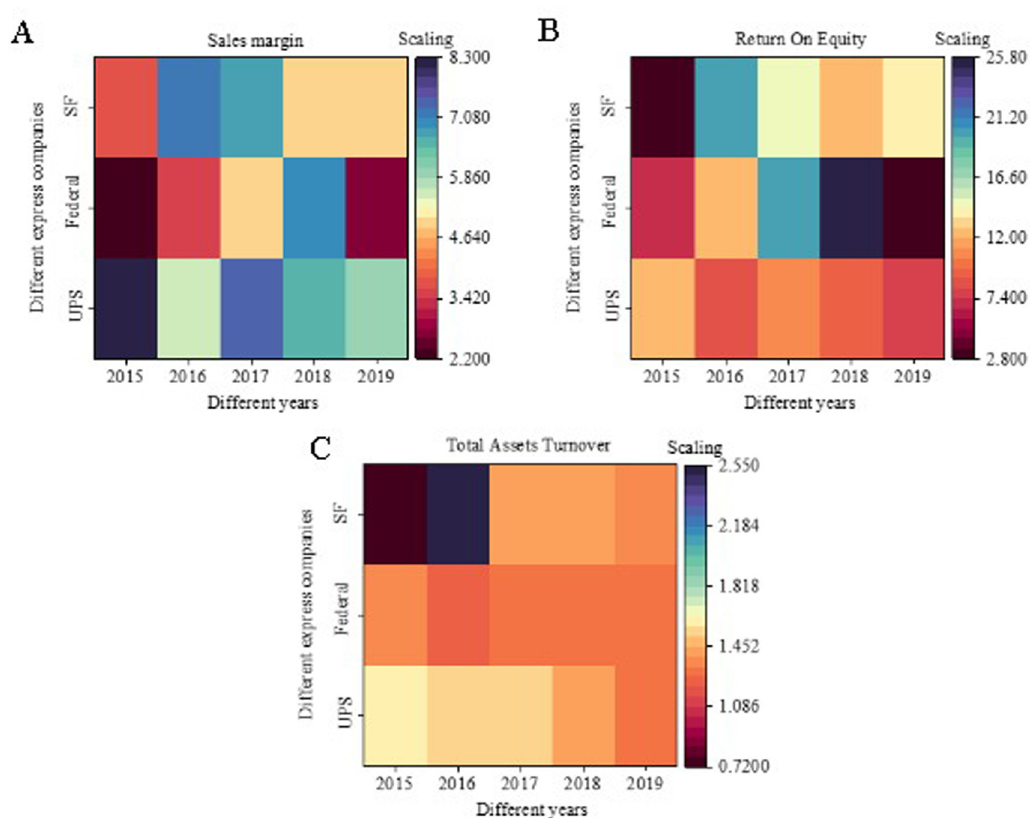
Fig 8. Financial indicator analysis results of global express enterprises.